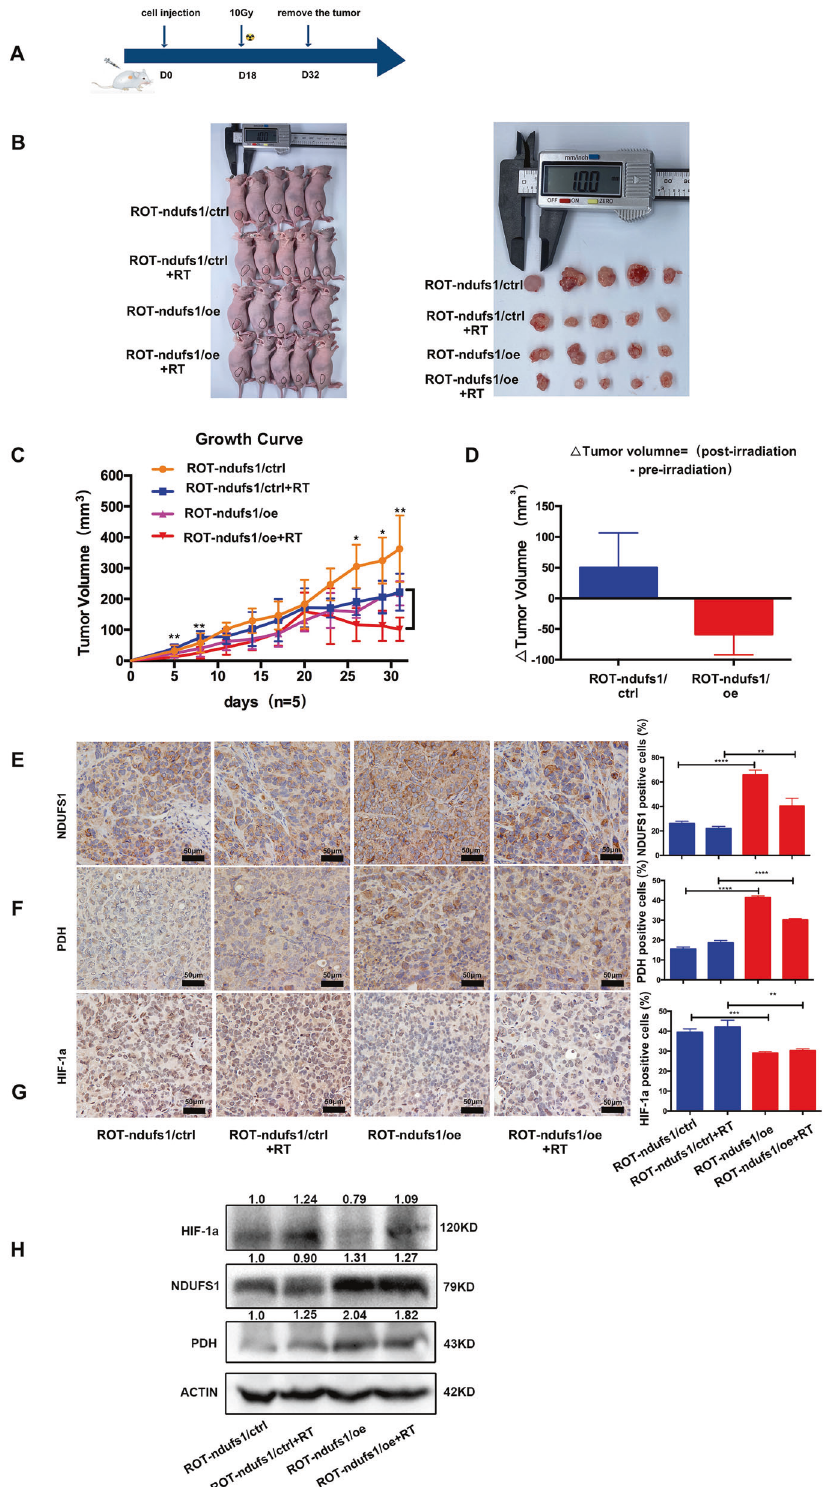
Fig. 6 NDUFS1-overexpression increased radiosensitivity in xenograft model. A Treatment schema. B Tumor images after all the mice were killed and tumors were removed. C Tumor size was measured every 3 days, control + irradiation vs oe + irradiation, ( n = 5), * P < 0.05 ** p < 0.01. D △ Tumor Volume = (post-irradiation-pre-irradiation) in ROT-ndufs1/ctrl and ROT-ndufs1/oe groups. E Representative images of IHC staining of NDUFS1in different tumor tissues. Brown: NDUFS1-positive cells. ( n = 3), ** P < 0.01, *** P < 0.001. F IHC staining of PDH in different tumor tissues. ( n = 3), **** P < 0.0001. G IHC staining of HIF-1 α in different tumor tissues. ( n = 3), ** P < 0.01, *** P < 0.001. H Expression of NDUF1, PDH, HIF-1a in tumor tissues by western blot. Data are presented as the means ± s.e.m.